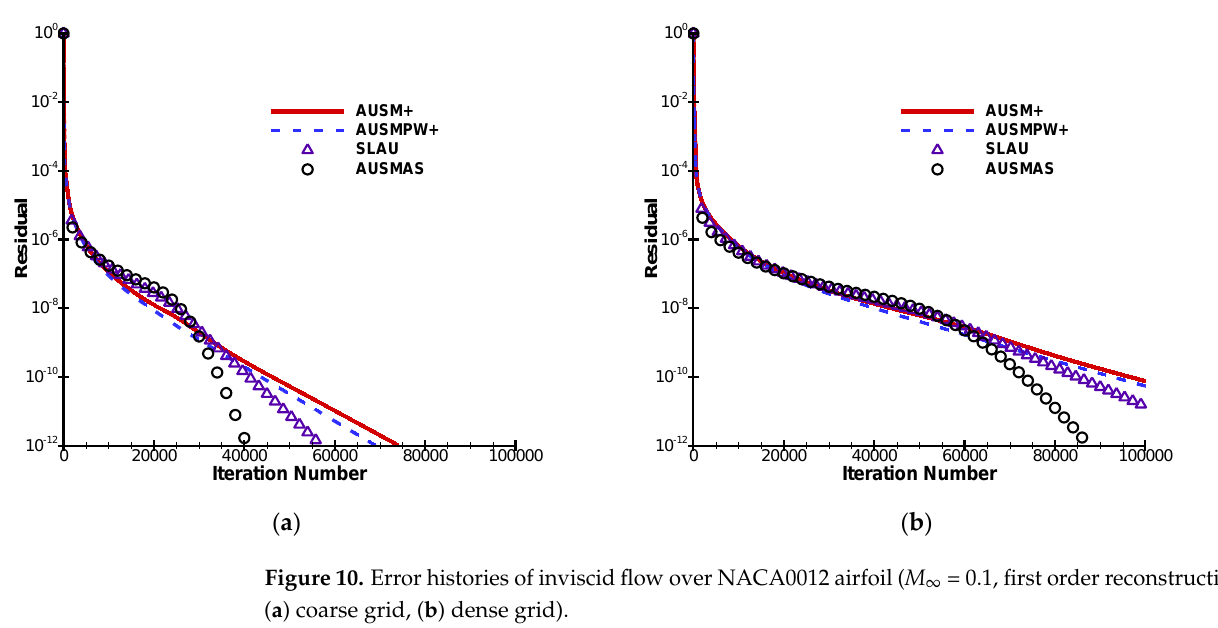
∞ = 0.1, first order reconstruction,